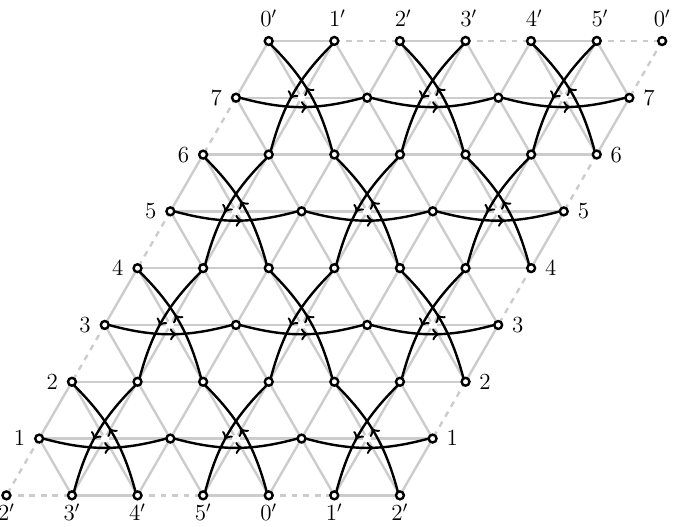
Figure 12 . Here we show another symmetric T 2 torus, periodic in the ϕ = 0 ◦ and ϕ 0 = 90 ◦ directions. The j → j lines ( j = 1 , 3 , 5 , 7 ) are unaffected by the altered boundary conditions (compared to figure 11), but now the ϕ = ± 120 ◦ mesons each form one closed ring of SU( N ) 12 . Reflections of the lattice in the ϕ = 0 ◦ or ϕ 0 = 90 ◦ directions exchange the ϕ = 120 ◦ and ϕ = 240 ◦ operators with each